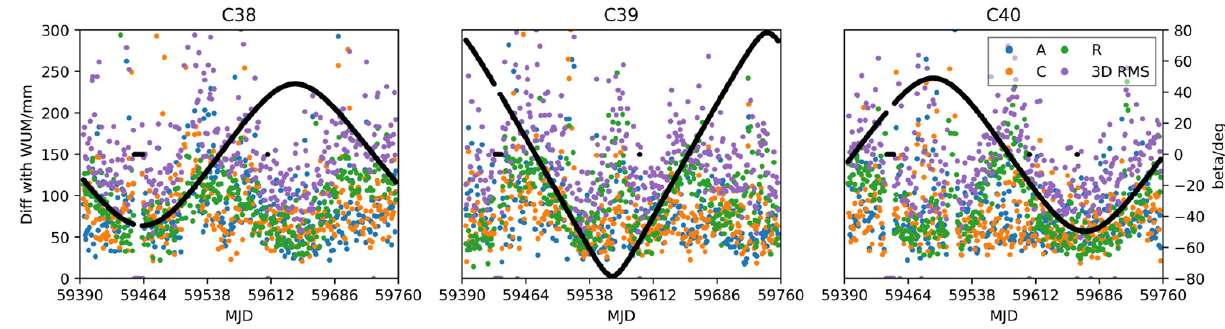
Figure 11. The IGSO orbit DBD time series of the CSNO Scheme in the along-track (A), cross-track (C), radial (R), and 3D RMS.